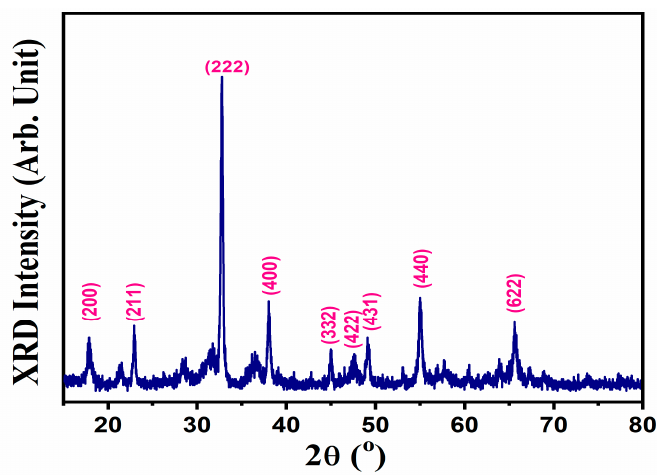
Figure 2. The XRD patterns of the synthesized mesoporous Mn 2 O 3 materials.